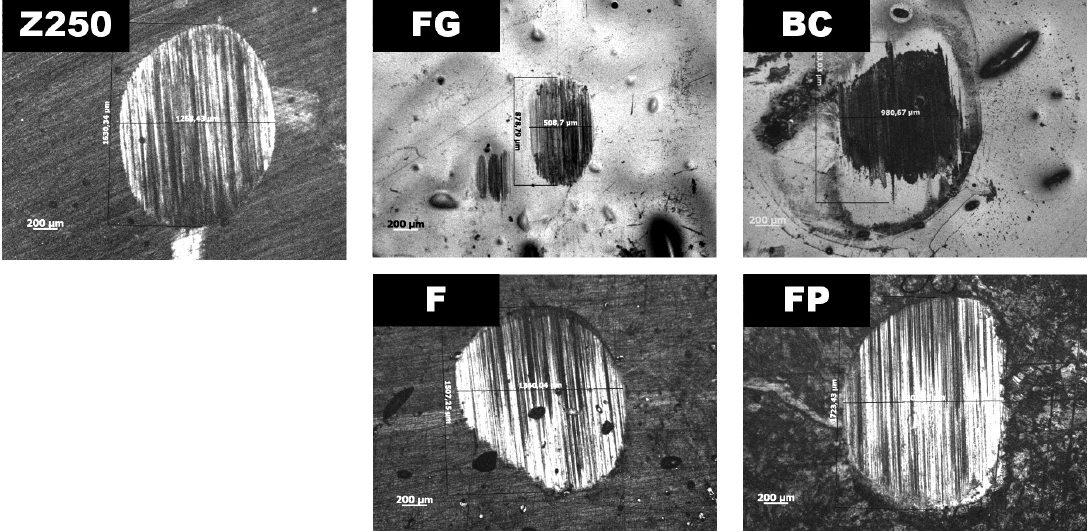
Figure 5. Optical microscopy of the wear scars formed on the following samples: bare Filtek Z250 ® composite resin (Z250), and Z250 samples filled with FillGlaze ® (FG), BisCover ® (BC), Fortify ® (F) and Fortify Plus ® (FP)